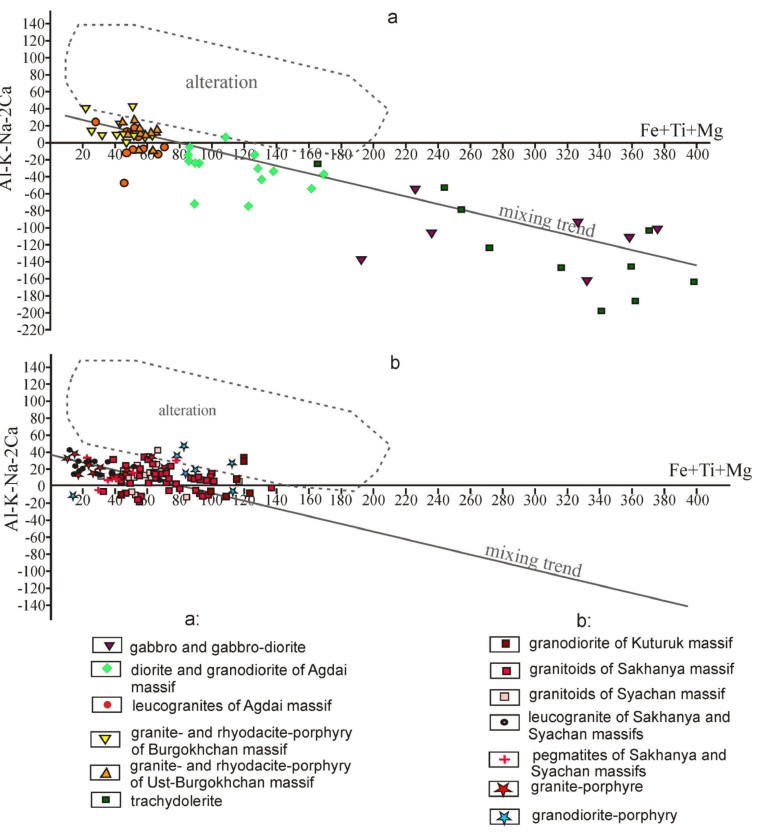
Figure 12. a–b diagram for the magmatic rocks of the Selennyakh River basin: ( a ) = Al – (K + Na + 2Ca); ( b ) = Fe + Ti = Mg—in gram-atoms